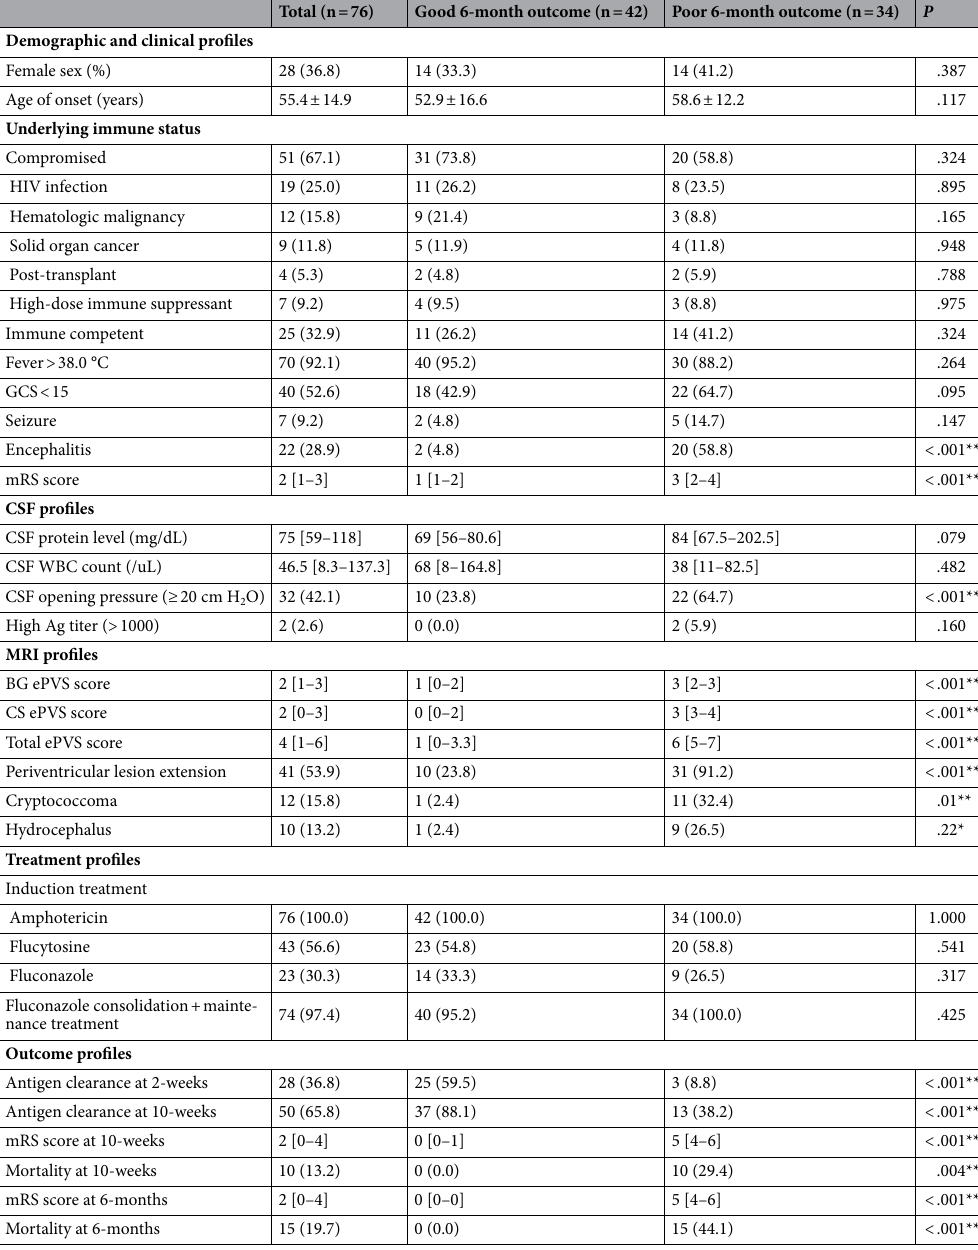
Fig. 4 for representative cases). The profiles of the MRI parameters between the groups evaluated using 1.5-T or 3.0-T MRI machines were comparable (Supplemental Table 4).